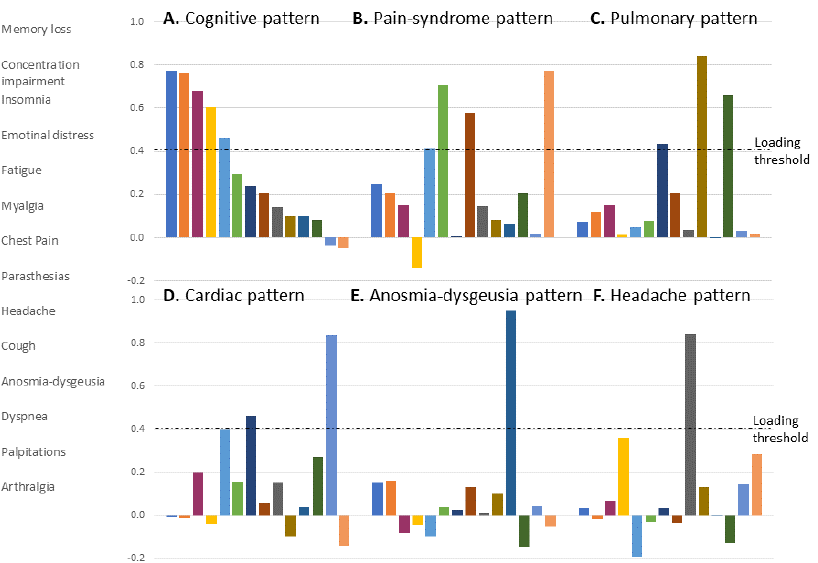
Figure 1. Loading of the different symptoms in each symptom pattern. ( A ) Cognitive-emotional pattern combining impaired cognitive functions, emotional distress, insomnia and fatigue (explaining 26.2% of variance); ( B ) Pain syndrome pattern combining myalgia, arthralgia, paresthesias and fatigue (9.5% of variance) ( C ) Pulmonary pattern combining dyspnea, cough and chest pain (8.5% of variance); ( D ) Cardiac—combining palpitations or tachycardia with chest pain (7.1% of variance), fatigue with a loading of 0.39 is under the threshold; ( E ) Anosmia-dysgeusia pattern—isolated anosmia and dysgeusia (6.8% of variance); ( F ) Headache pattern—isolated headache (6.5% of variance); The 6 factors in total explain 64.6% of variance between the recoverees; KMO: 0.811, Bartlett’s test of sphericity chi-square: 2682.51, p < 0.001. Table 2. Patterns associations with selected demographics, comorbidities and features of the acute disease. Means for each of the patterns with standard deviation in parenthesis are shown. Significant associations a marked in bold. Analysis by t -test (Spearman where